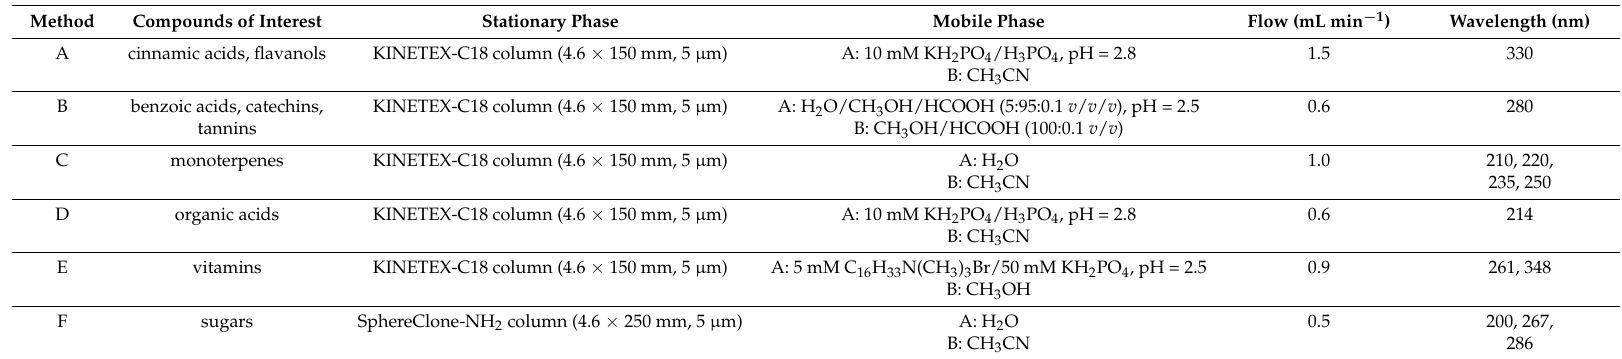
Table 5. Chromatographic conditions of the used